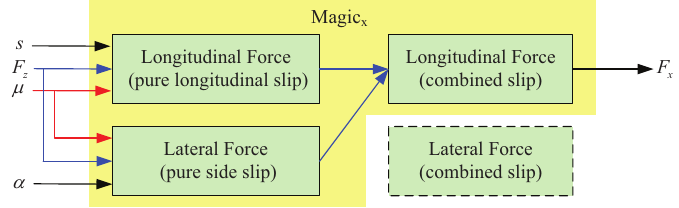
Figure 5. Structure of the Magic